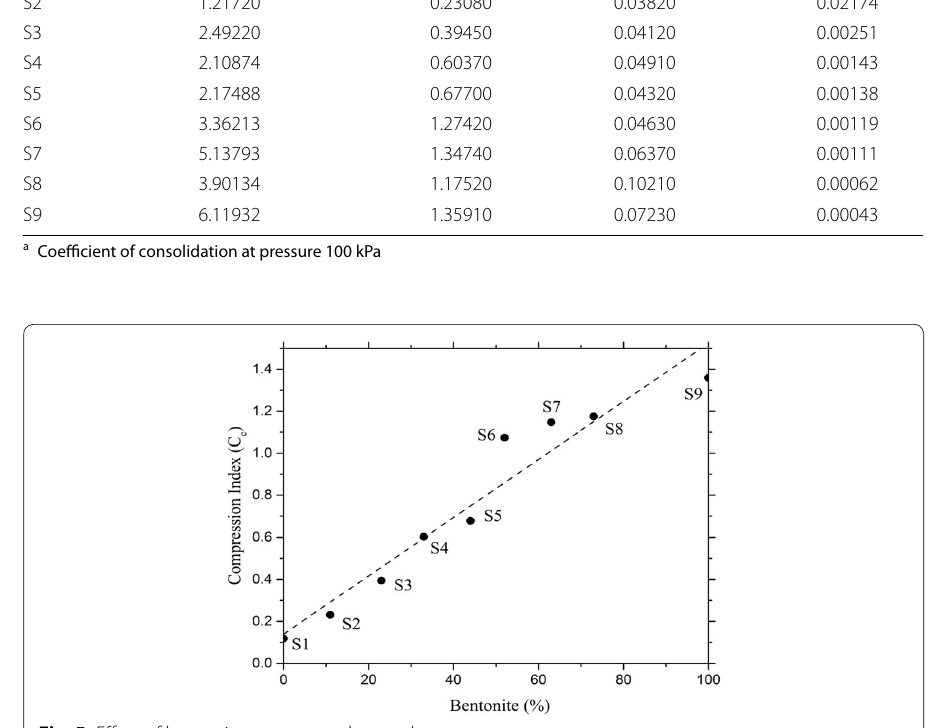
Fig. 5 Effect of bentonite content on the c c